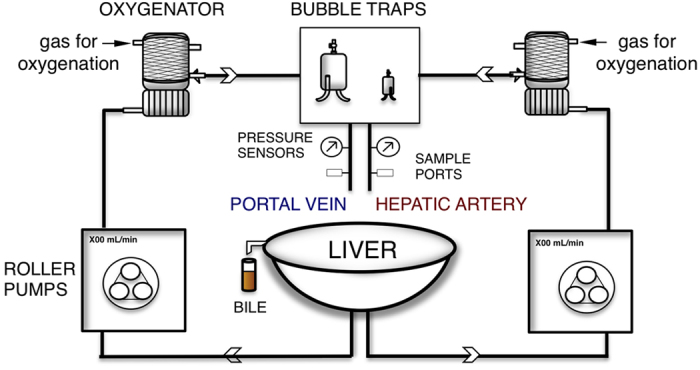
Schematic representation of the SNMP system.Two parallel circulations provide continuous flow of oxygenated perfusate to the liver through the portal vein (left) and hepatic artery (right). Flow and pressure on the vessels are monitored continuously. Oxygenation of the perfusate was provided by membrane oxygenators using carbogen gas(95% O2/5% CO2) mixture. The temperature is ambiently maintained at 21 ± 0.3 °C. The pressure of the system is controlled by flow adjustments to achieve target pressures of 3–7 mmHg and 30–80 mmHg on the PV and HA, respectively.